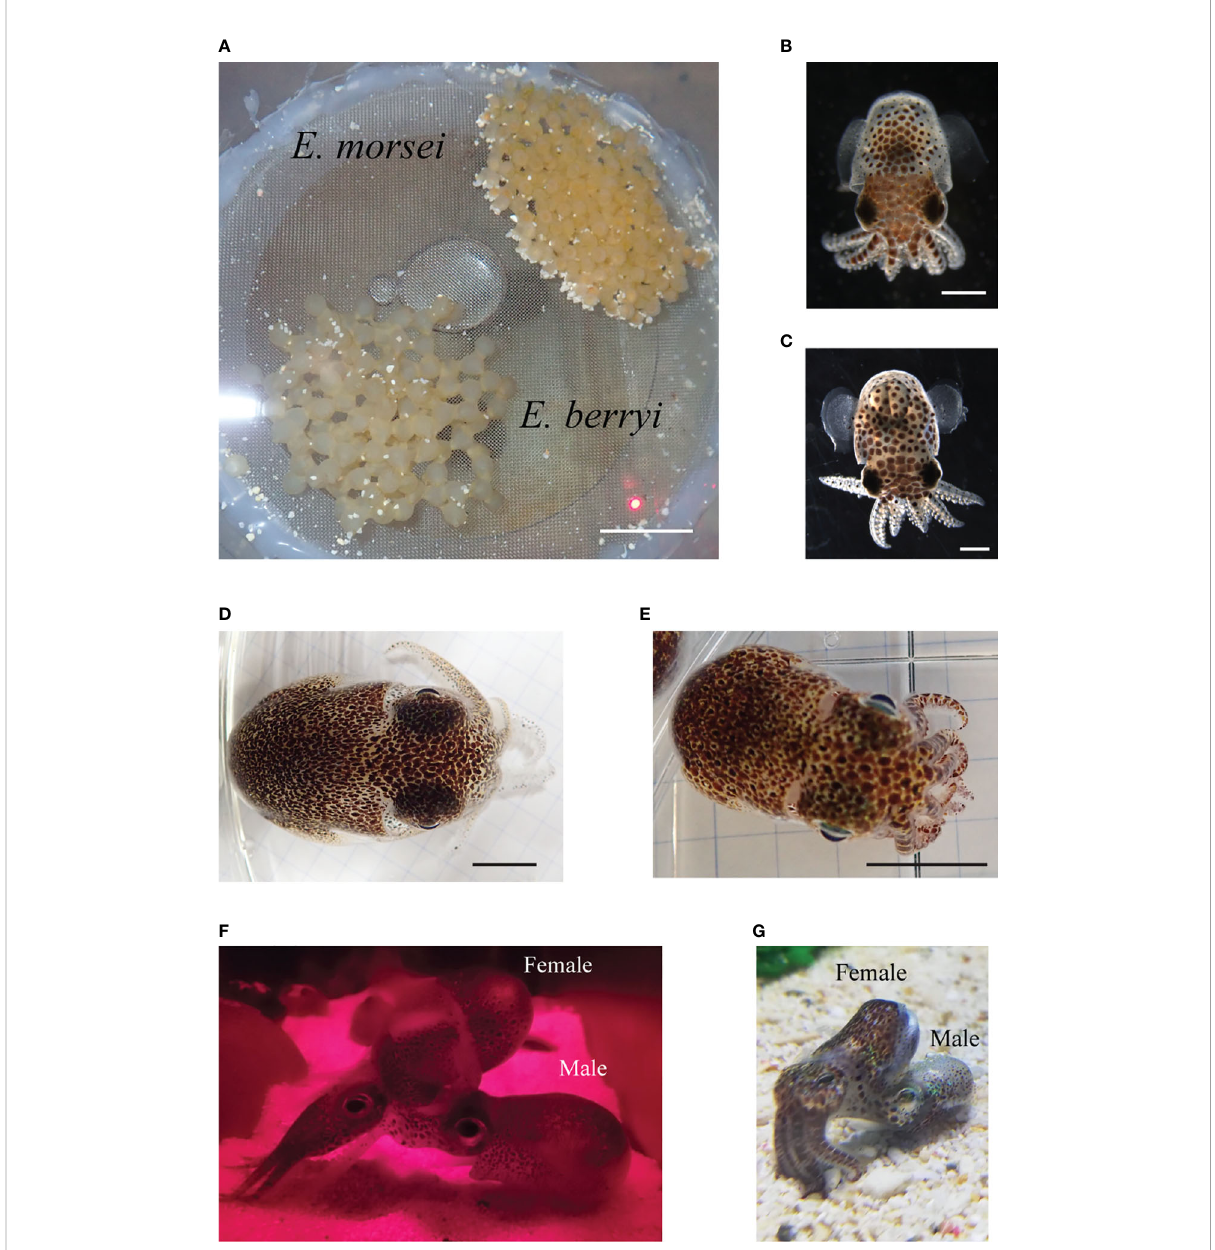
FIGURE 2 E berryi and E morsei at different life stages. (A) Egg clutches of E berryi (left) and E morsei (right). Scale bar is 5 cm. (B) E berryi at one day post- hatching (dph). Scale bar is 1 mm. (C) E morsei at one dph. Scale bar is 1mm. (D) Mature E berryi at 130 dph. Scale bar is 1 cm. (E) Mature E morsei at 70 dph. Scale bar is 1 cm. (F) E berryi mating. The male (on the right) grasps the female from the ventral side to engage mating. (G) E morsei mating. The smaller male on the right grasps the female from the ventral side to engage